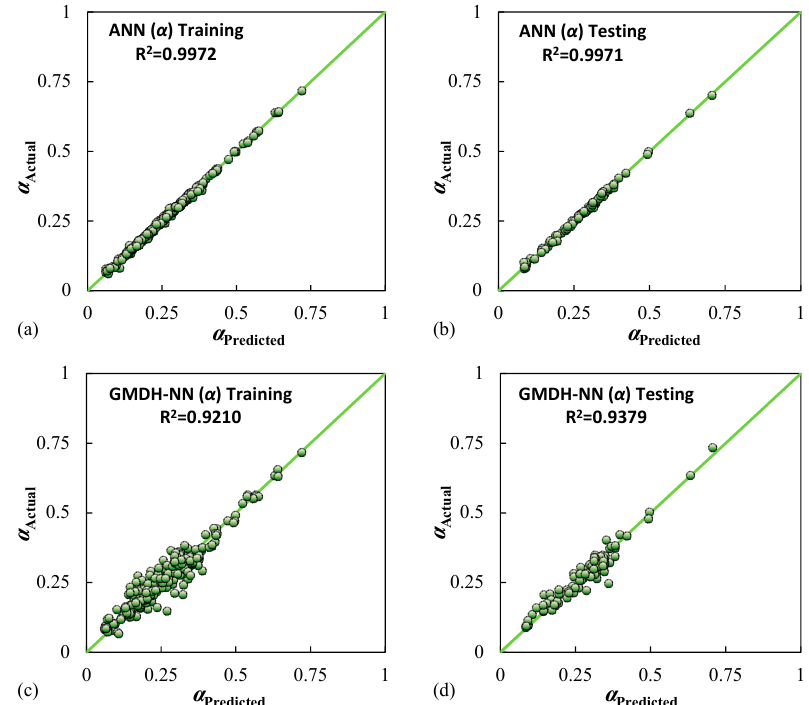
Figure 18. Measured vs. predicted α for training and testing stages using: ( a ) and ( b ) ANN ( β ); ( c ) and ( d ) GMDH-NN ( β ).